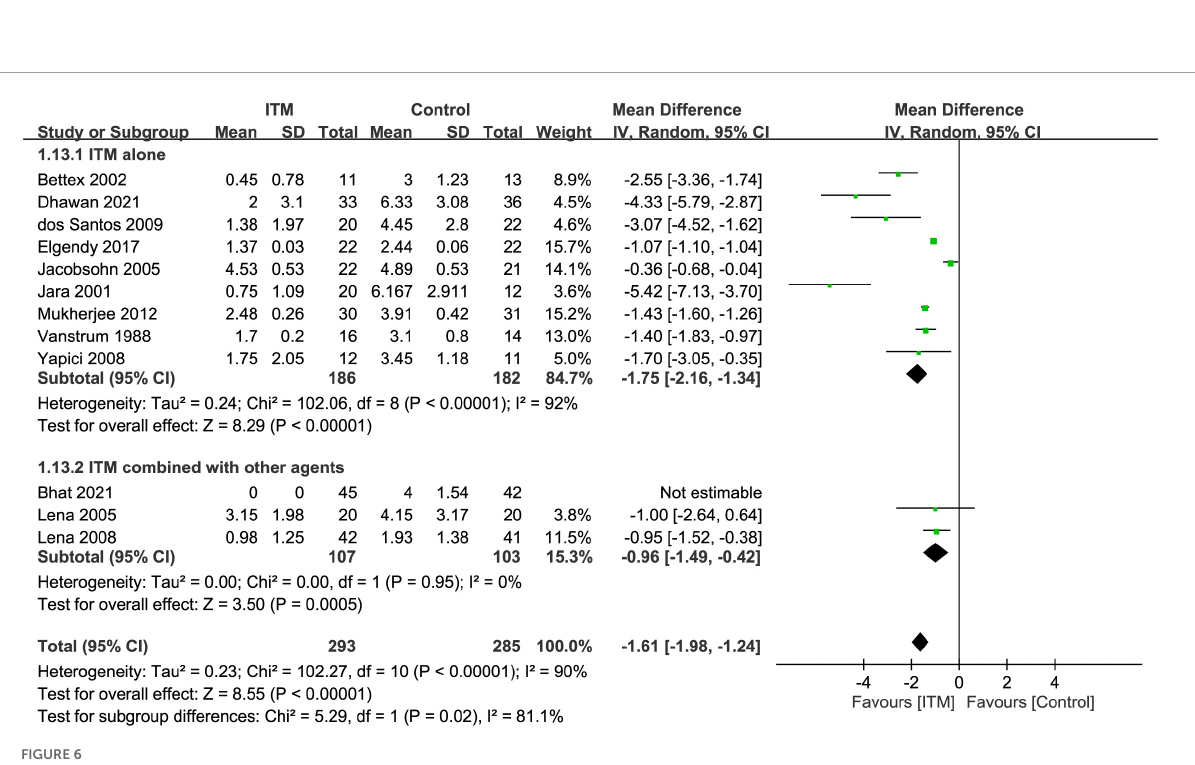
FIGURE6 Subgroup analysis comparing postoperative 24-h pain score between intrathecal morphine (ITM) and control groups based on the use of intrathecal agents. CI, confidence interval; IV, inverse variance; SD, standard